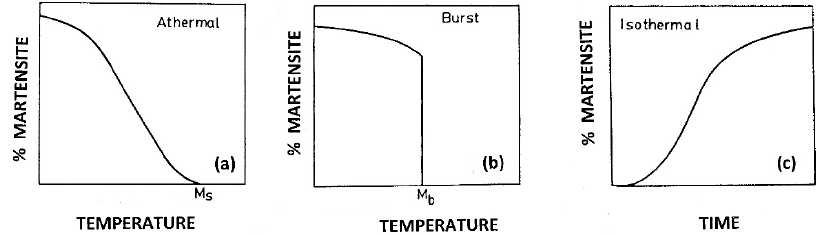
Figure 1. Schematic diagrams showing the three kinetic modes of martensitic transformation: ( a ) athermal; ( b ) burst; and ( c ) isothermal. After [13].